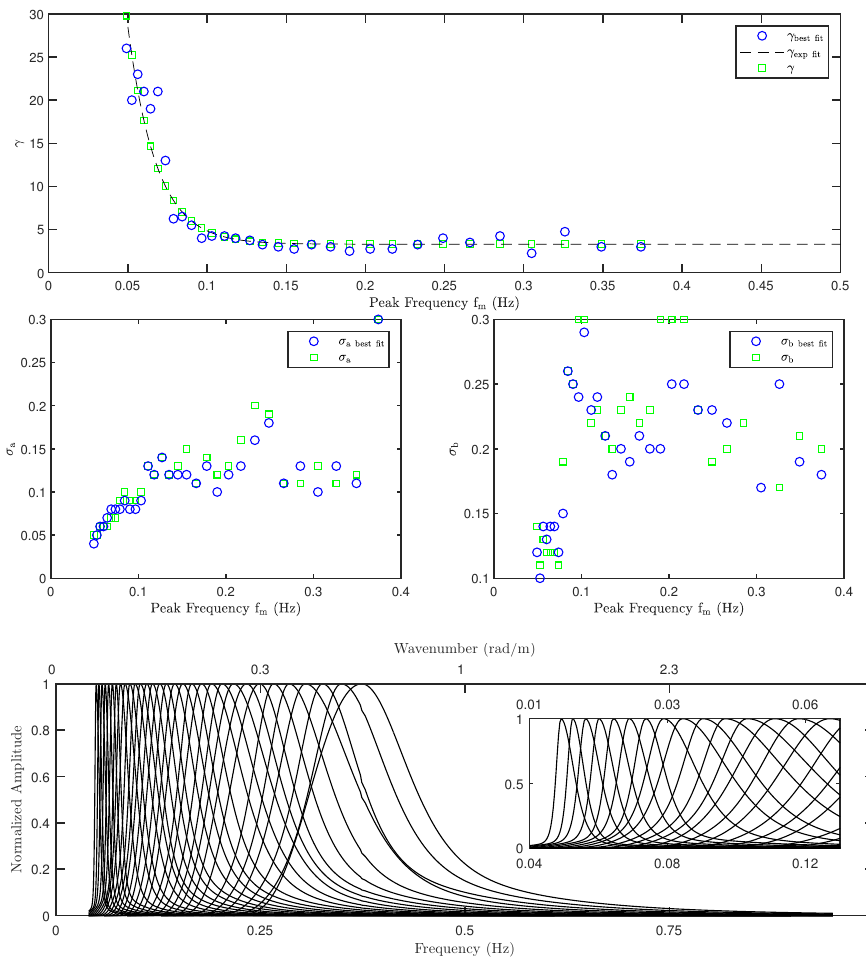
Figure 10. JONSWAP peak shape parameters extended to the swell-dominated region as a function of peak frequency based on NDBC buoy data. Variations in γ , σ a , and σ b are shown in ( top ), ( middle left ), and ( middle right ) figures, respectively. The ( bottom ) figure shows resulting normalized 1D swell spectral shapes ¯ S s ( f ) . See text for